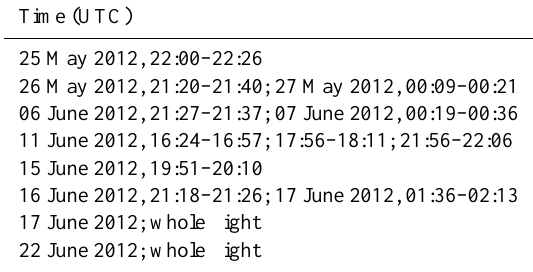
Table 2. Periods of identified biomass-burning